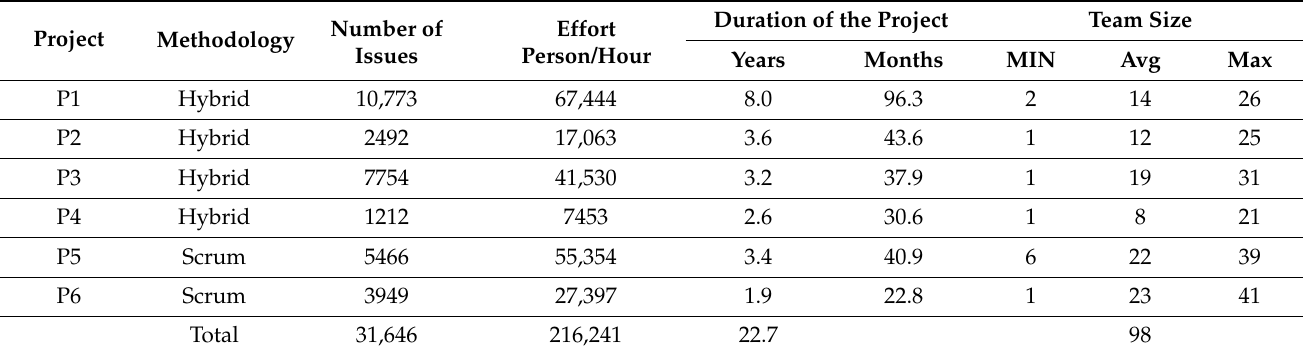
Table 1. Projects, the data of which were used for research on task